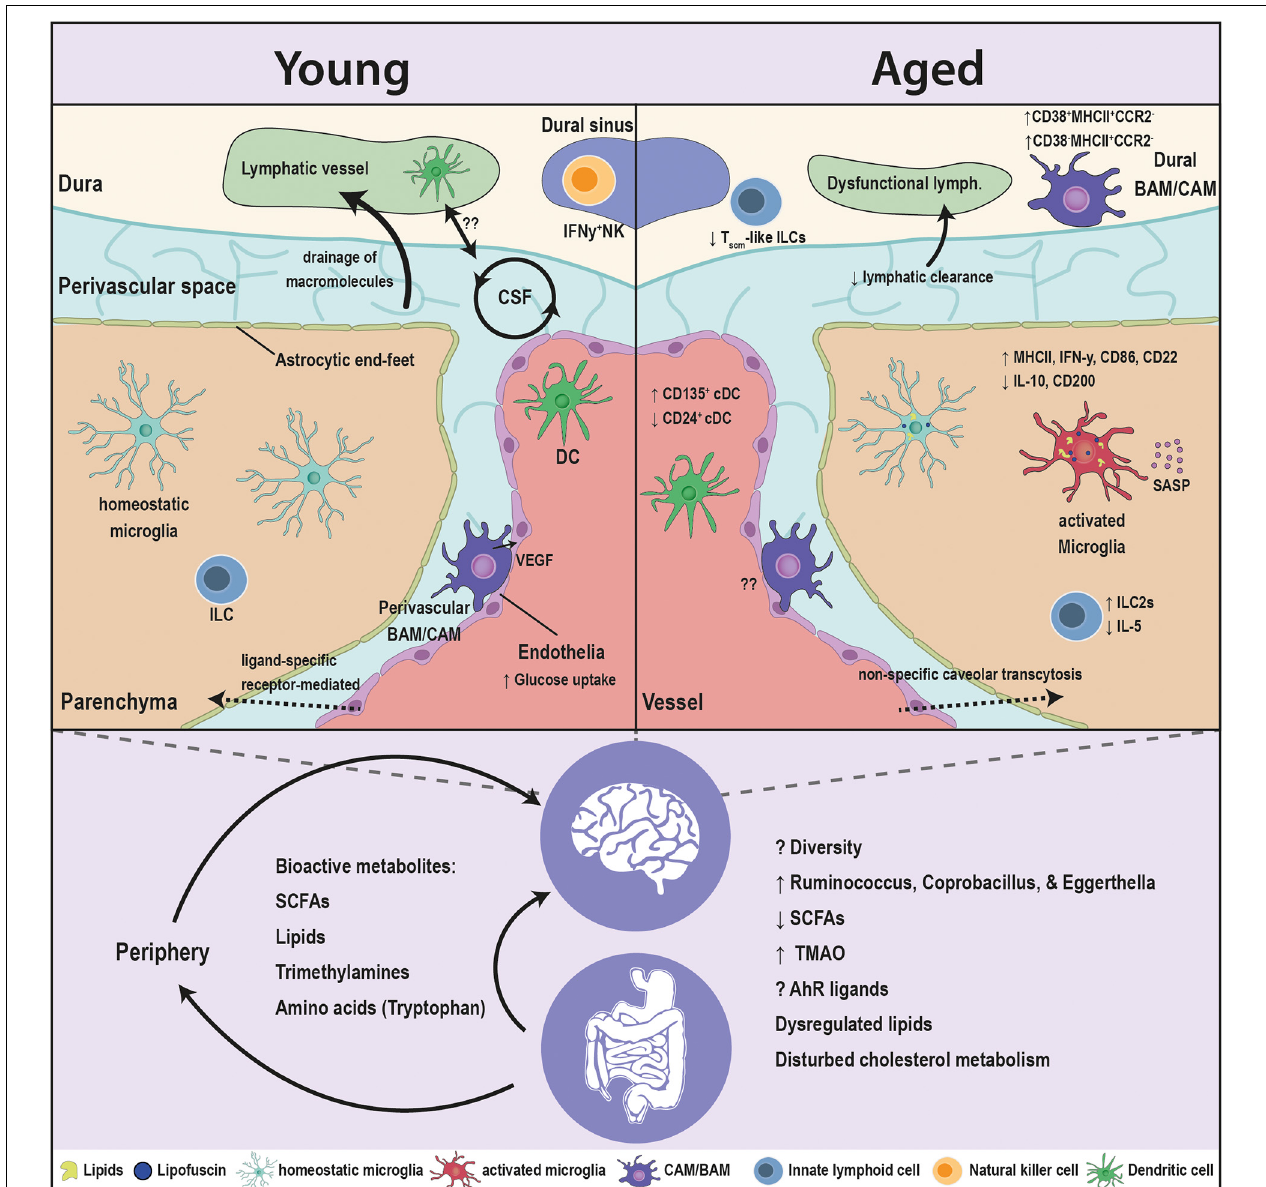
FIGURE 1 | Age-associated alterations in the brain innate immunity and the gut microbiota. Major crippling and life-threatening diseases, such as cancer, cardiovascular disease, and neurodegeneration, are all linked to advanced age. The innate immune cells are the first responders to insults in the brain, and are in constant communication with the microbiota. Aging has several facets on the brain, as well as the microbiota. The blood brain barrier (BBB) switches from ligand-receptor transport to a less specific caveolar transcytosis. The drainage of the CSF macromolecules declines and is associated to dysfunctional changes in the lymphatics and innate immune cells. Microglia, the brain resident macrophages, switch to an age-related phenotype in which microglia accumulate lipofuscin and lipid droplets, elicit a pro-inflammatory profile [elevation in major histocompatibility complex (MHC) class II, interferon gamma (IFN- γ ), cluster of differentiation 86 (CD86), and cluster of differentiation 22 (CD22), and a reduction in interleukin-10 (IL-10) and cluster of differentiation 200 (CD200)], decreased phagocytic capacity and an induction of senescence-associated secretory phenotype (SASP). CNS- or border-associated macrophages (BAMs/CAMs) undergo numerous brain-maintaining functions in the healthy young brain that decline with age. BAMs/CAMs shit to CD38 + MHCII + CCR2 − and CD38 − MHCII + CCR2 − subsets in the aged brain. Classical dendritic cells (DCs) associated with the brain elicit an elevation in CD135 + and a drop in CD24 + subsets. Innate lymphoid cells (ILCs) switch from IL1C to IL2C transcriptomic profile and lessen the expression of the neuroprotective interleukin 5 (IL-5). Moreover, the microbiota interacts with cell populations of the brain both directly and indirectly through modulating the periphery. Multitudes of microbiota-derived molecules [short chain fatty acids (SCFAs), lipids, trimethylamines, amino acids] influence the activity of the brain innate immune cells and in turn modulate the brain functions. The levels of these bioactive metabolites are sensitive to age. The fine tuning of these molecules is disturbed in aging, due to compositional changes in the microbiota and the drop in the taxonomic diversity. Alterations in the microbiota are decisive to the dysregulation of immune function of the brain’s innate immunity in aging and requires more comprehensive research.